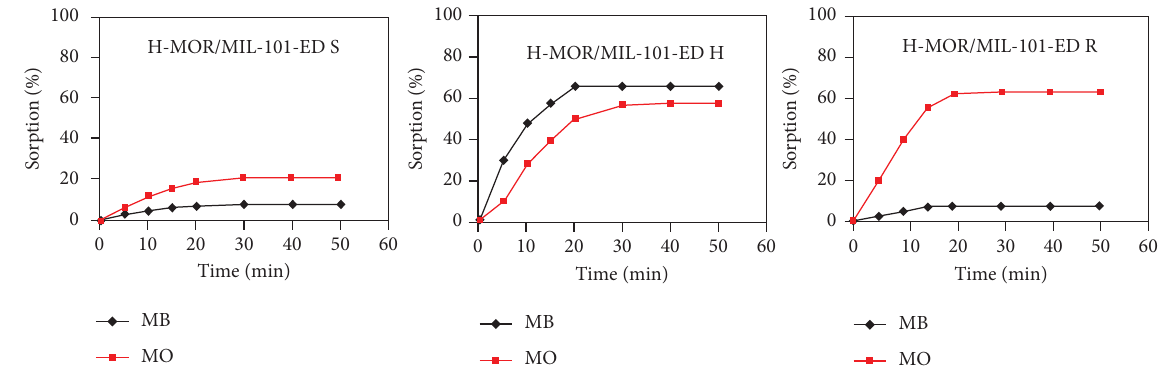
Figure 35: Adsorption of MB and MO dyes by H-MOR@MIL-101-ED composites at optimized condition, of 5mg adsorbent, 25ppm dyes, and at 25 ° C adopted from